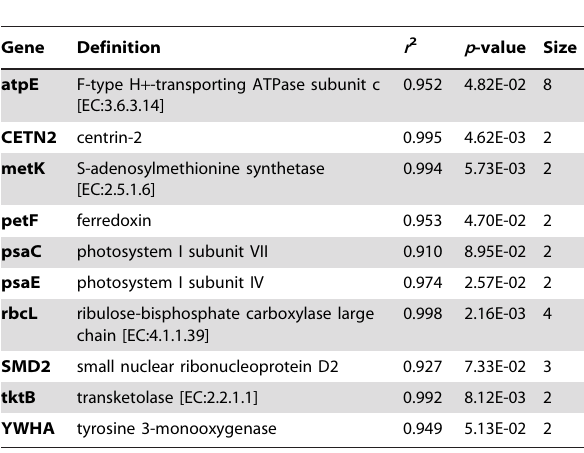
Table 3. Gene families with significant within-family co-regulated expression